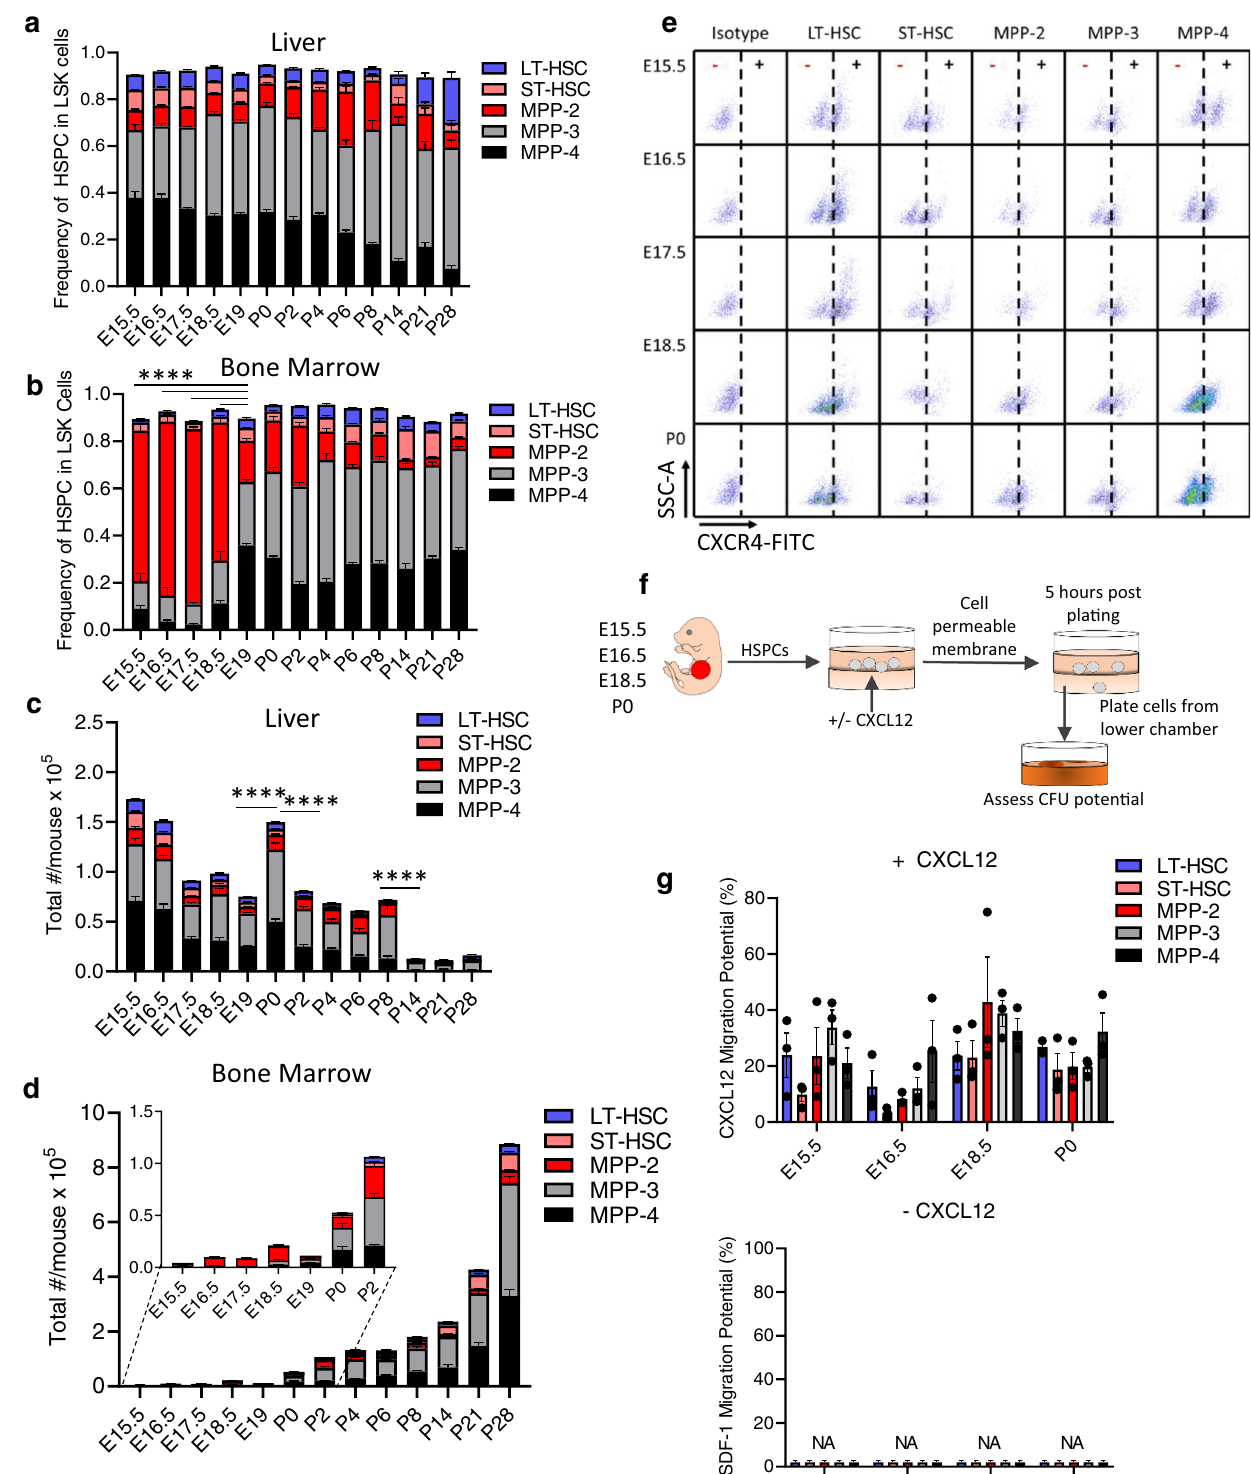
Fig. 2 | FBMHSPCfrequencyisdistinctfrom FLandadult BM. FrequencyinLSK cells( a , b )andabsolutenumber( c , d )ofHSPCsinmurineliver( a , c )andBM( b , d ). Data are means±SE of 10 – 17 embryos from 2 – 3 litters. **** in b : P <0.0001 com- paring MPP2 frequencies; **** in c : P <0.0001 comparing total HSPC numbers. e Representative fl ow cytometry of cell-surface CXCR4 on E15.5-P0 FL HSPCs ( n =2 – 3). f CXCL12 trans-well migration assay. g Migration of fetal and newborn